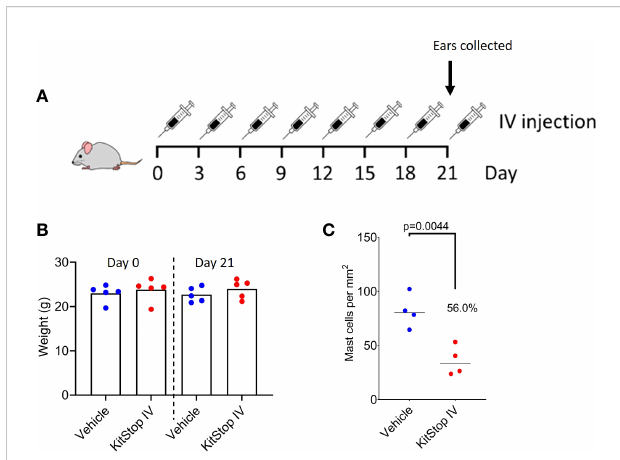
FIGURE 3 Systemic KitStop ESO treatment reduces the number of cutaneous mast cells in ear skin. (A) Five Balb/c mice were treated intravenously with PBS vehicle control or KitStop ESO every 3 days for 21 days. Ears were harvested and evaluated histologically with H&E and toluidine blue stains to facilitate counting of tissue MCs. (B) No signi fi cant changes in body weight were observed between mice treated with PBS vehicle control (blue) or KitStop ESO (red) at the end of the 21- day treatment period. (C) The total number of mast cells per mm2 of ear skin was signi fi cantly reduced by 56% in KitStop-treated mice. Data shown are the mean ± SEM for each group. P values are from an unpaired